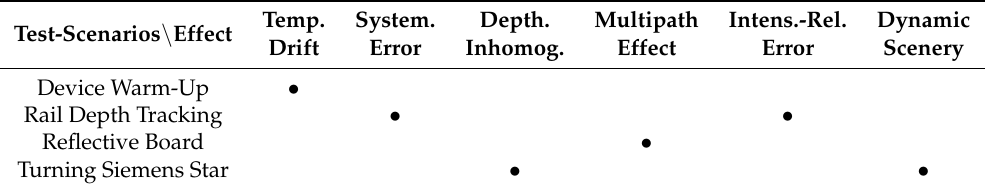
Table 3. The relation between the different ToF effects to the designed test scenarios. Each test addresses primarily one or two separable effects denoted by • . Test-Scenarios \ Effect